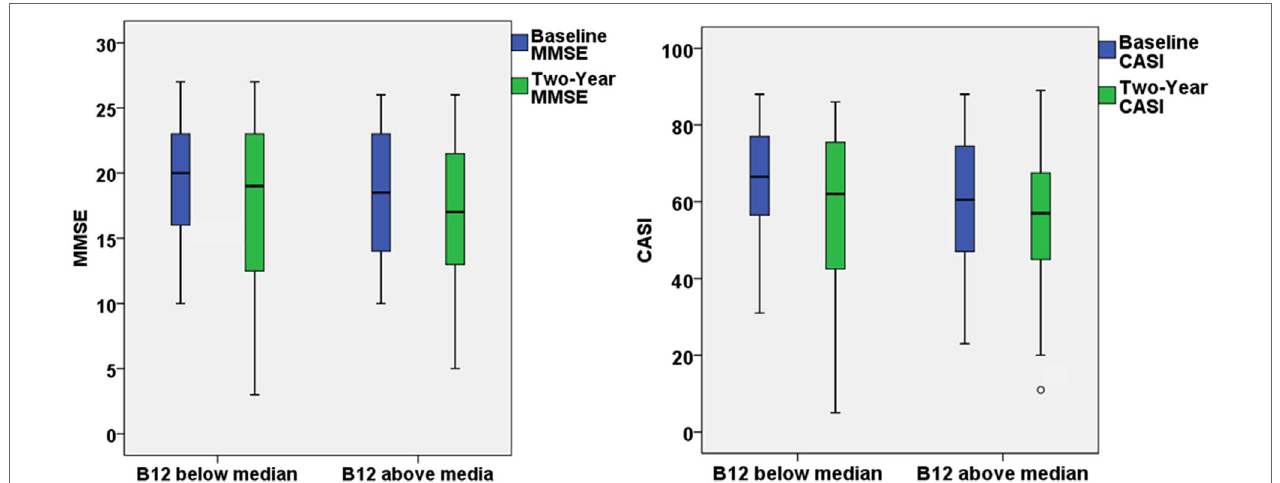
FigUre 1 | The box plots demonstrated the results of Mini–Mental State Examination (MMSE) and Cognitive Abilities Screening Instrument (CASI) at baseline and 2-year follow-up for patients with optimal ( > 436 ng/L) or suboptimal baseline vitamin B12